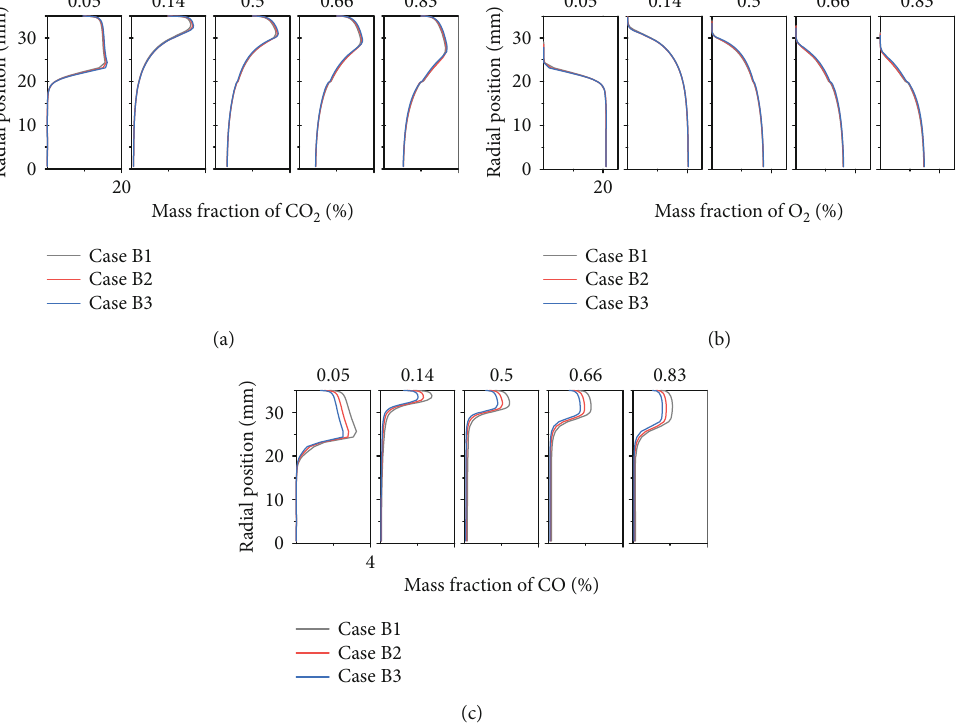
(a), O (b), and CO (c) for the cases with di ff erent inlet mass fl ow rates. 2 2